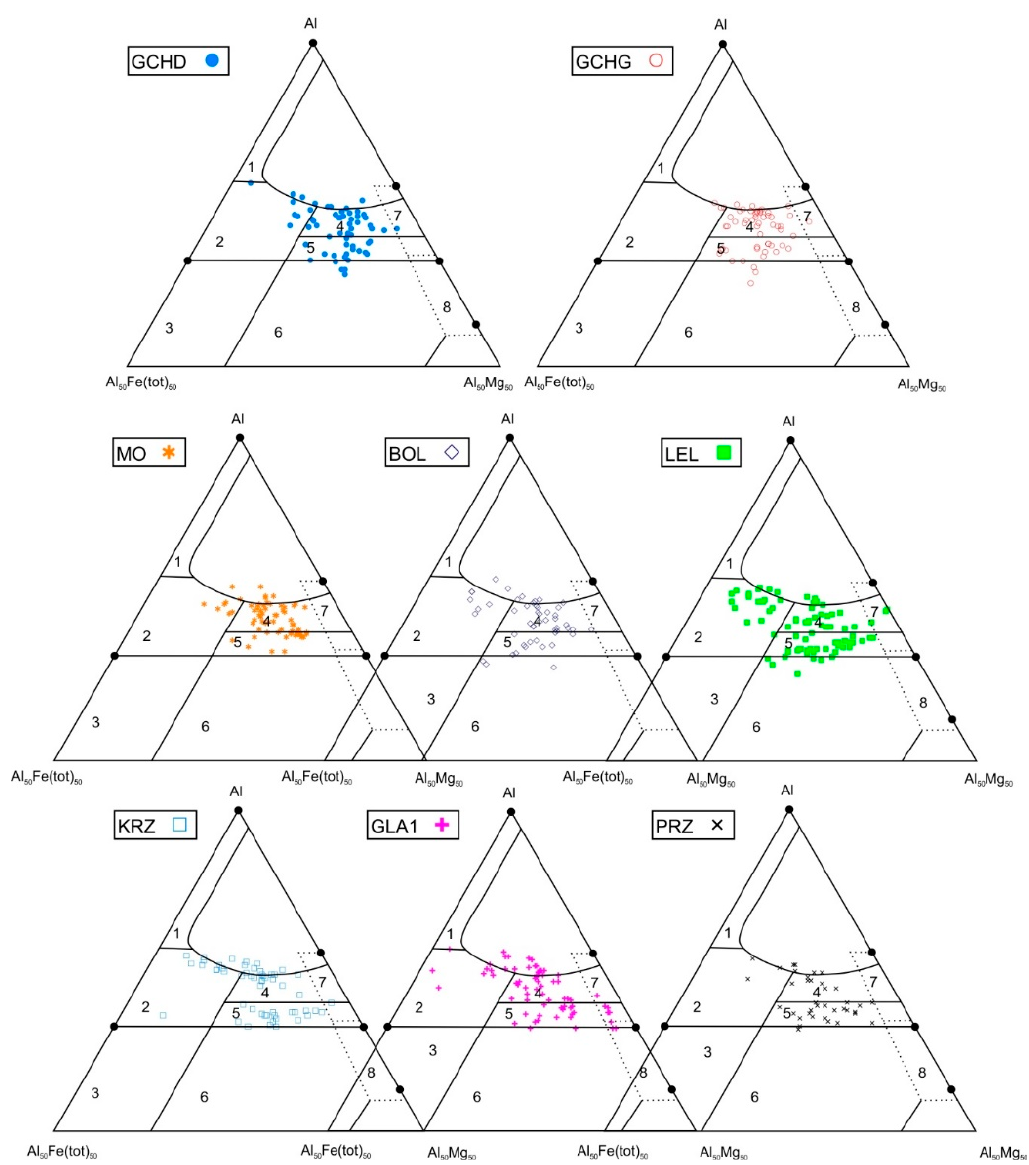
Figure 8. Fe–Al–Mg ternary discrimination diagrams of Henry and Guidotti [69] showing compositions of tourmaline from the Miech ó w Segment, southern Poland. The distinguished discrimination fields are: ( 1 ) Li-rich granitoid pegmatites and aplites; ( 2 ) Li-poor granitoids and their associated pegmatites and aplites; ( 3 ) Fe 3 + -rich quartz-tourmaline rocks (hydrothermally altered granites); ( 4 ) Metapelites and metapsammites coexisting with an Al-saturating phase; ( 5 ) Metapelites and metapsammites not coexisting with an Al-saturating phase; ( 6 ) Fe 3 + -rich quartz-tourmaline rocks, calc-silicate rocks, and metapelites; ( 7 ) Low-Ca metaultramafics and Cr, V-rich metasediments; ( 8 ) Metacarbonates and meta-pyroxenites.